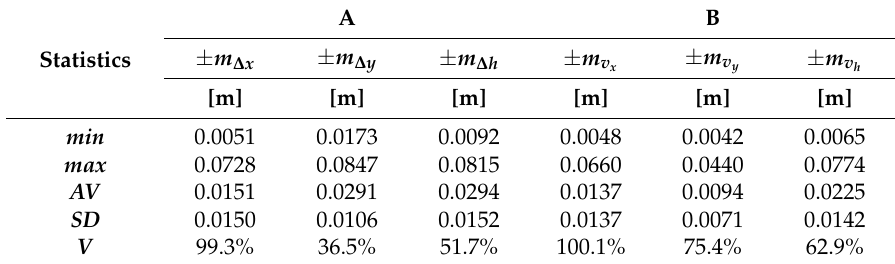
Table 12. List of basic measurement statistics, respectively: A—without taking into account the reduction of absolute errors, B—after taking into account the reduction of absolute errors